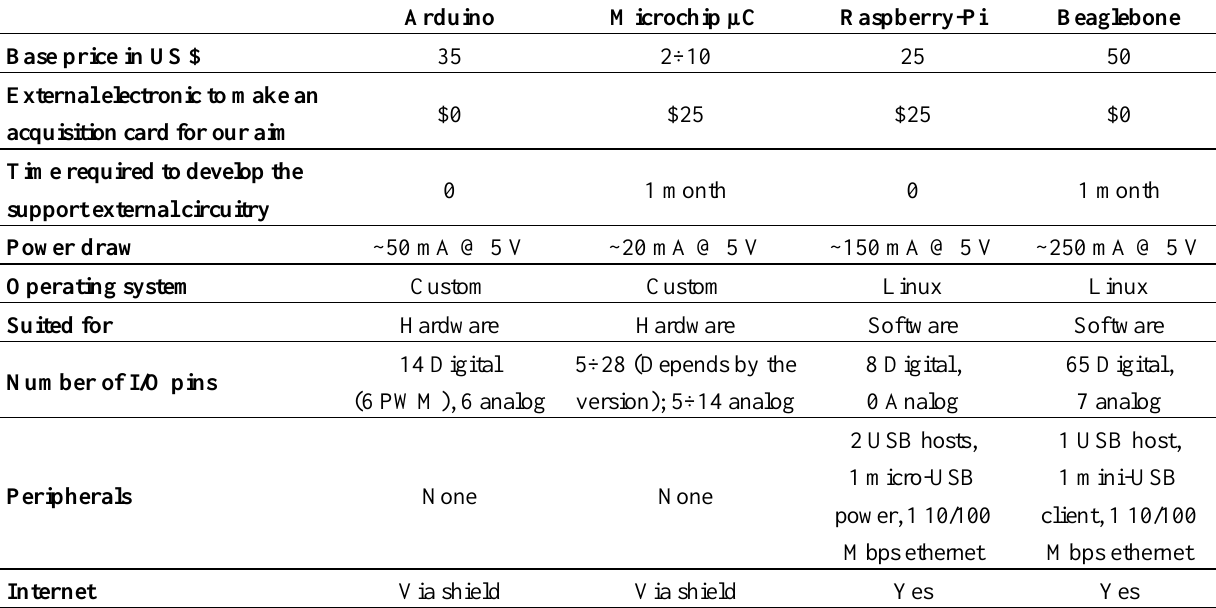
Table 1. Arduino vs. Microchip microcontrollers, Raspberry-Pi and